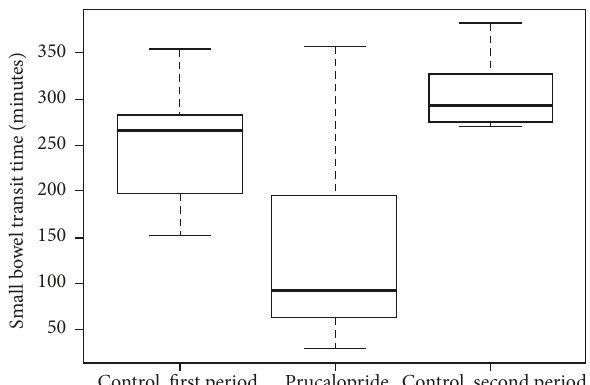
Figure 2: Box plot diagrams showing the distributions of small bowel transit time in the three study periods. Control, first period (October 2011 to March 2014); the period of prucalopride use (from March 2014 to December 2015); control, second period (December 2015 to September 2016).